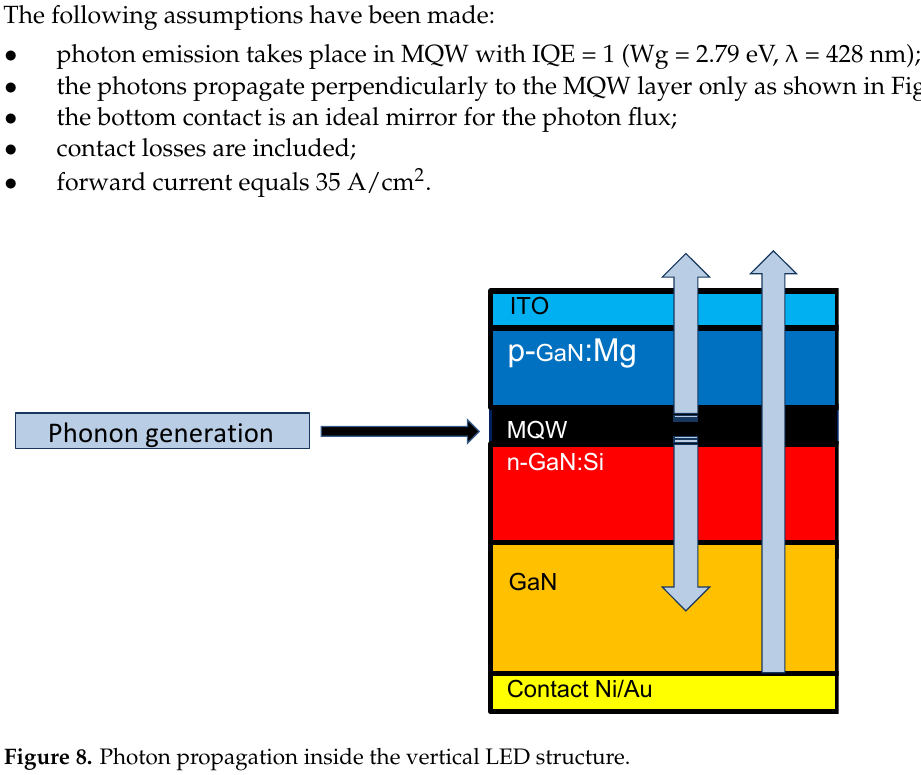
Figure 8. Photon propagation inside the vertical LED structure. Table 2. Evaluation of energy exchange at contacts and in processes of radiative recombination, photon absorption, and ohmic losses that take place in particular layers of the considered GaN LED structure. Layer